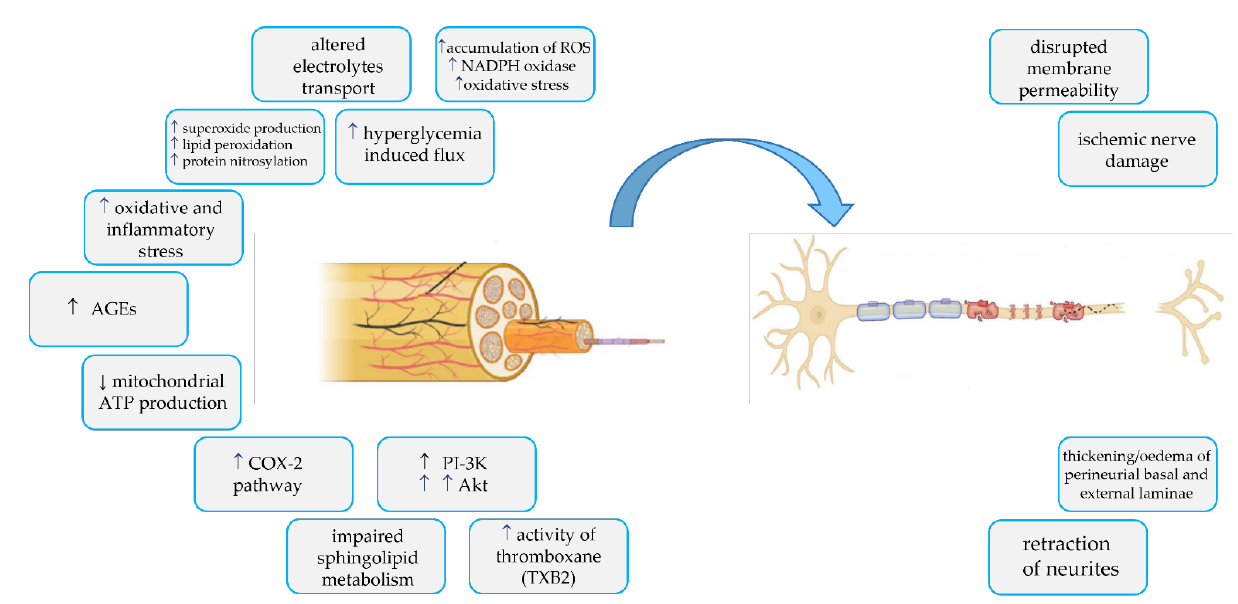
Figure 1. Main pathophysiological mechanisms of DPN.